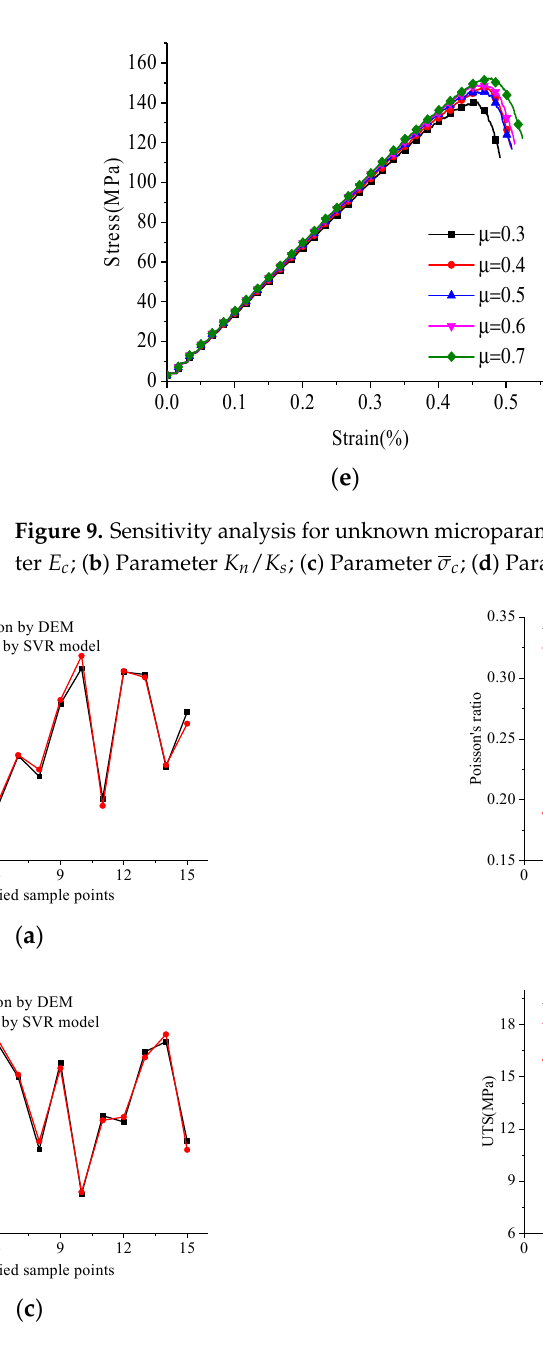
Figure 10. The verification for SVR models. ( a ) Yong’s modulus; ( b ) Poisson’s ratio; ( c ) UCS; ( d ) UTS.